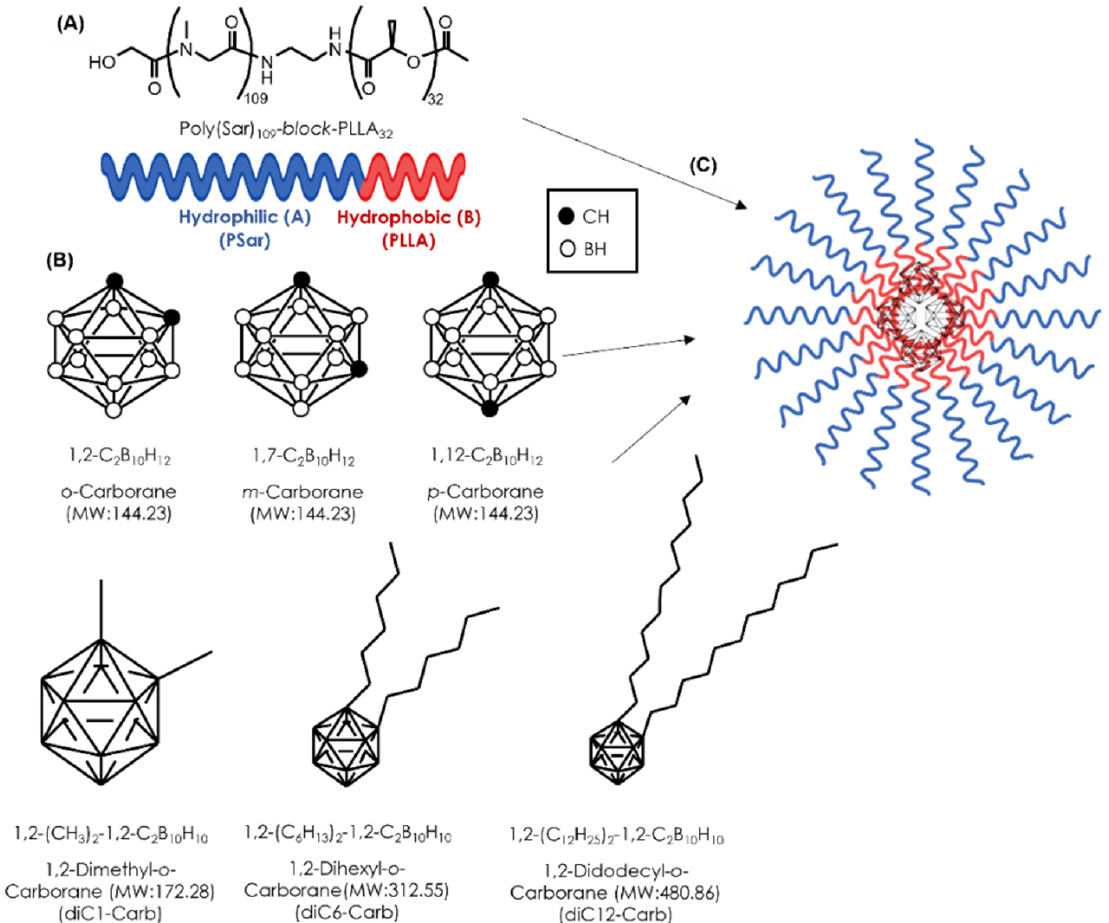
Figure 1. The structural concept of a novel DDS for BNCT. The structure of the AB-Lac particles ( A ); the chemical structure of hydrophobic B compounds ( B ); the schematic illustration of the AB-Lac particles loaded with a hydrophobic B compound ( C ).